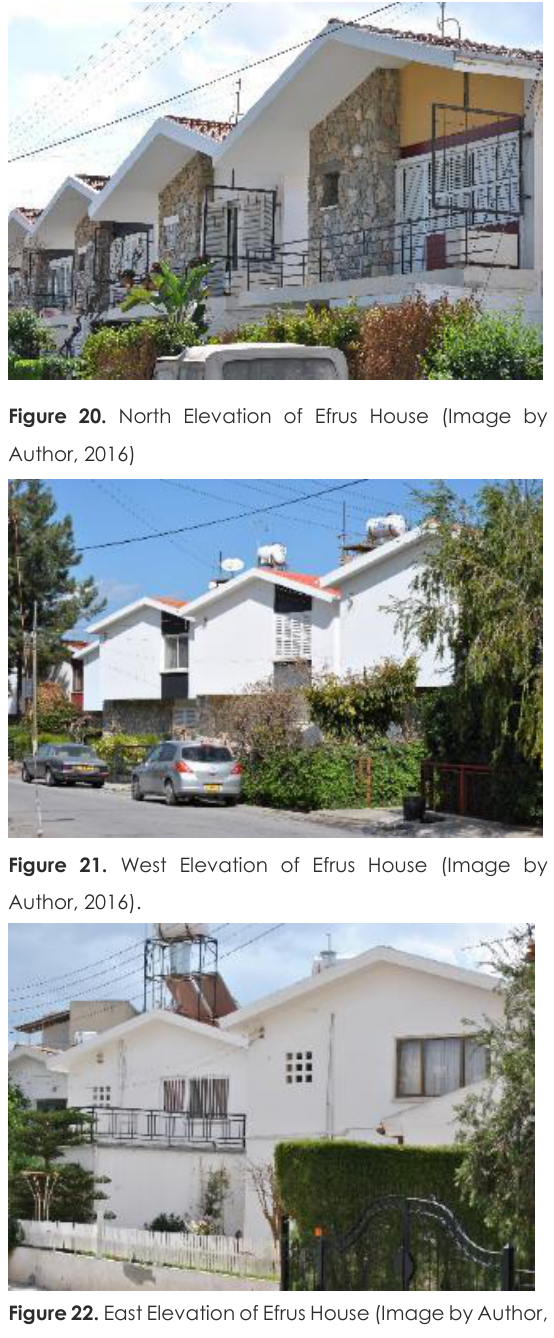
Figure 22. East Elevation of Efrus House (Image by Author, 2016).